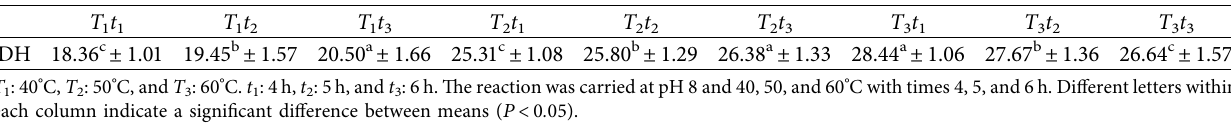
Table 2: Interaction efects of temperature and time on DH